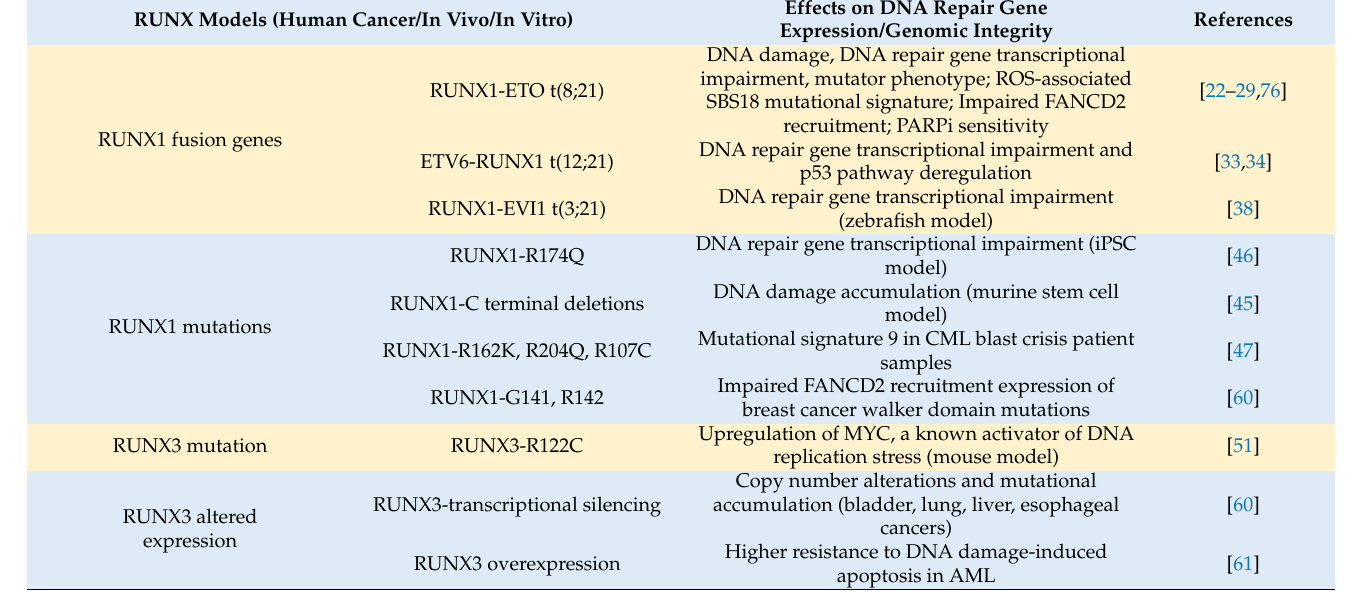
Table 1. A summary on the relationship between RUNX proteins, DNA repair, and cancer. Effects on DNA Repair Gene RUNX Models (Human Cancer/In Vivo/In Vitro) Expression/Genomic